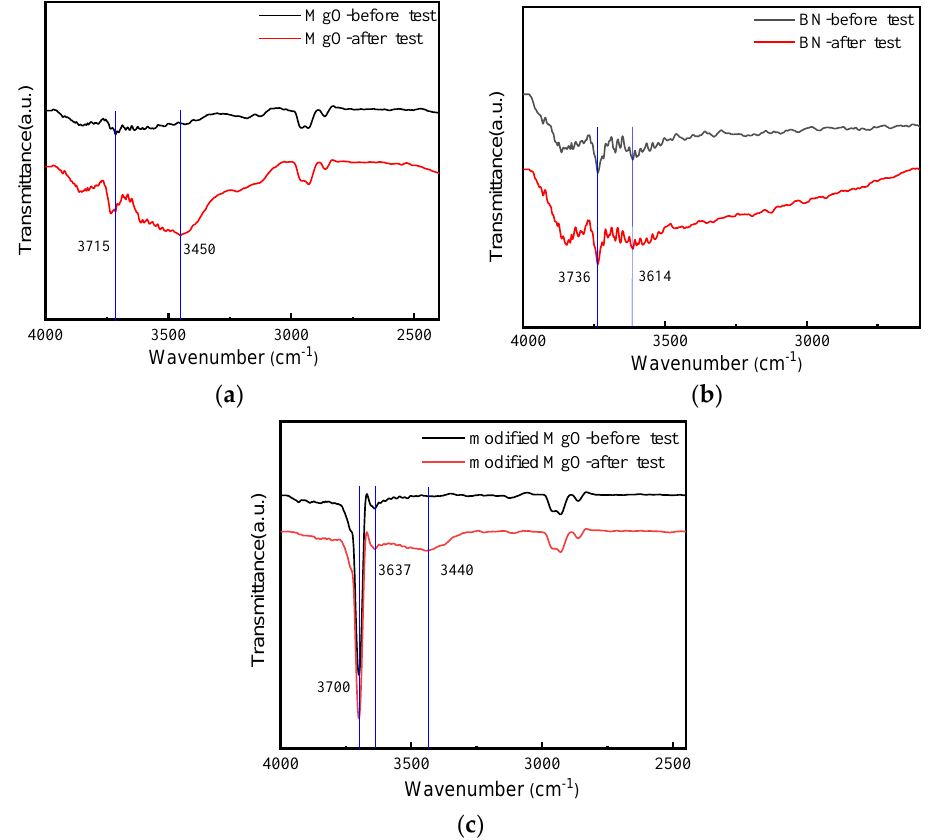
Figure 8. FTIR of powders before and after TDS measurement. ( a ) MgO powders; ( b ) BN powders; ( c ) modified MgO powders.